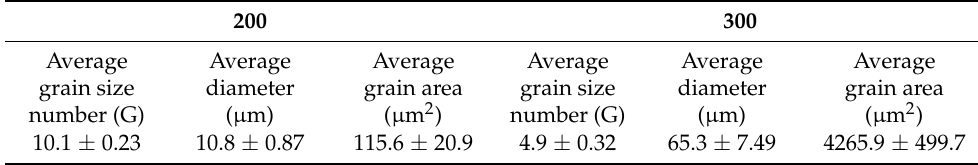
Table 2. Grain size analysis of the steels.